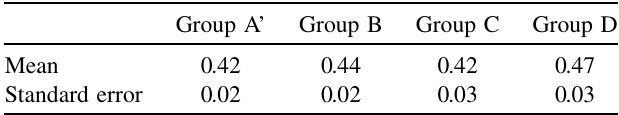
TABLE XV. Average group presentation grades for post prob- lem.